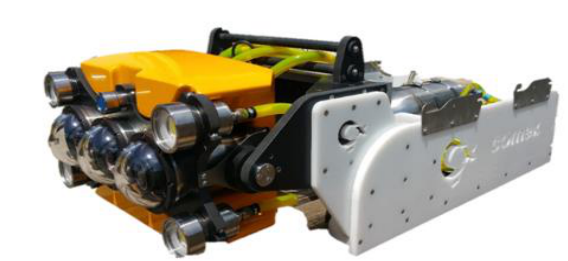
Figure 3. The ORUS 3D 3Kv system mounted on a Mid-Size observation class ROV